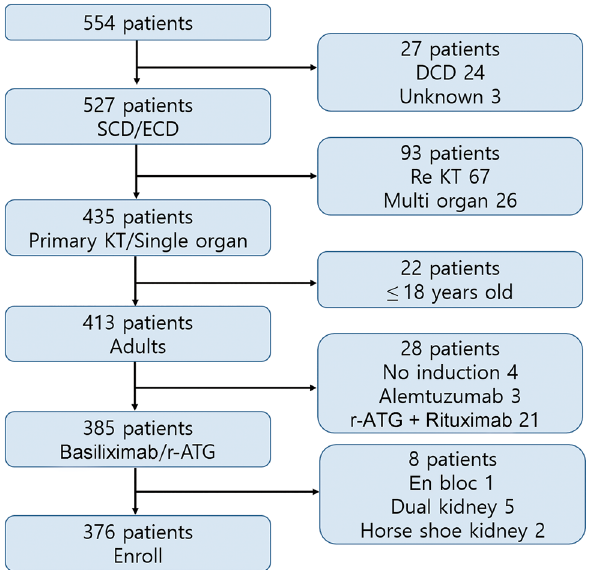
Figure 5. Flow chart of the patient selection process. SCD standard criteria donor, ECD expanded criteria donor, DCD donation after circulatory death, KT kidney transplantation, r-ATG rabbit anti-thymocyte